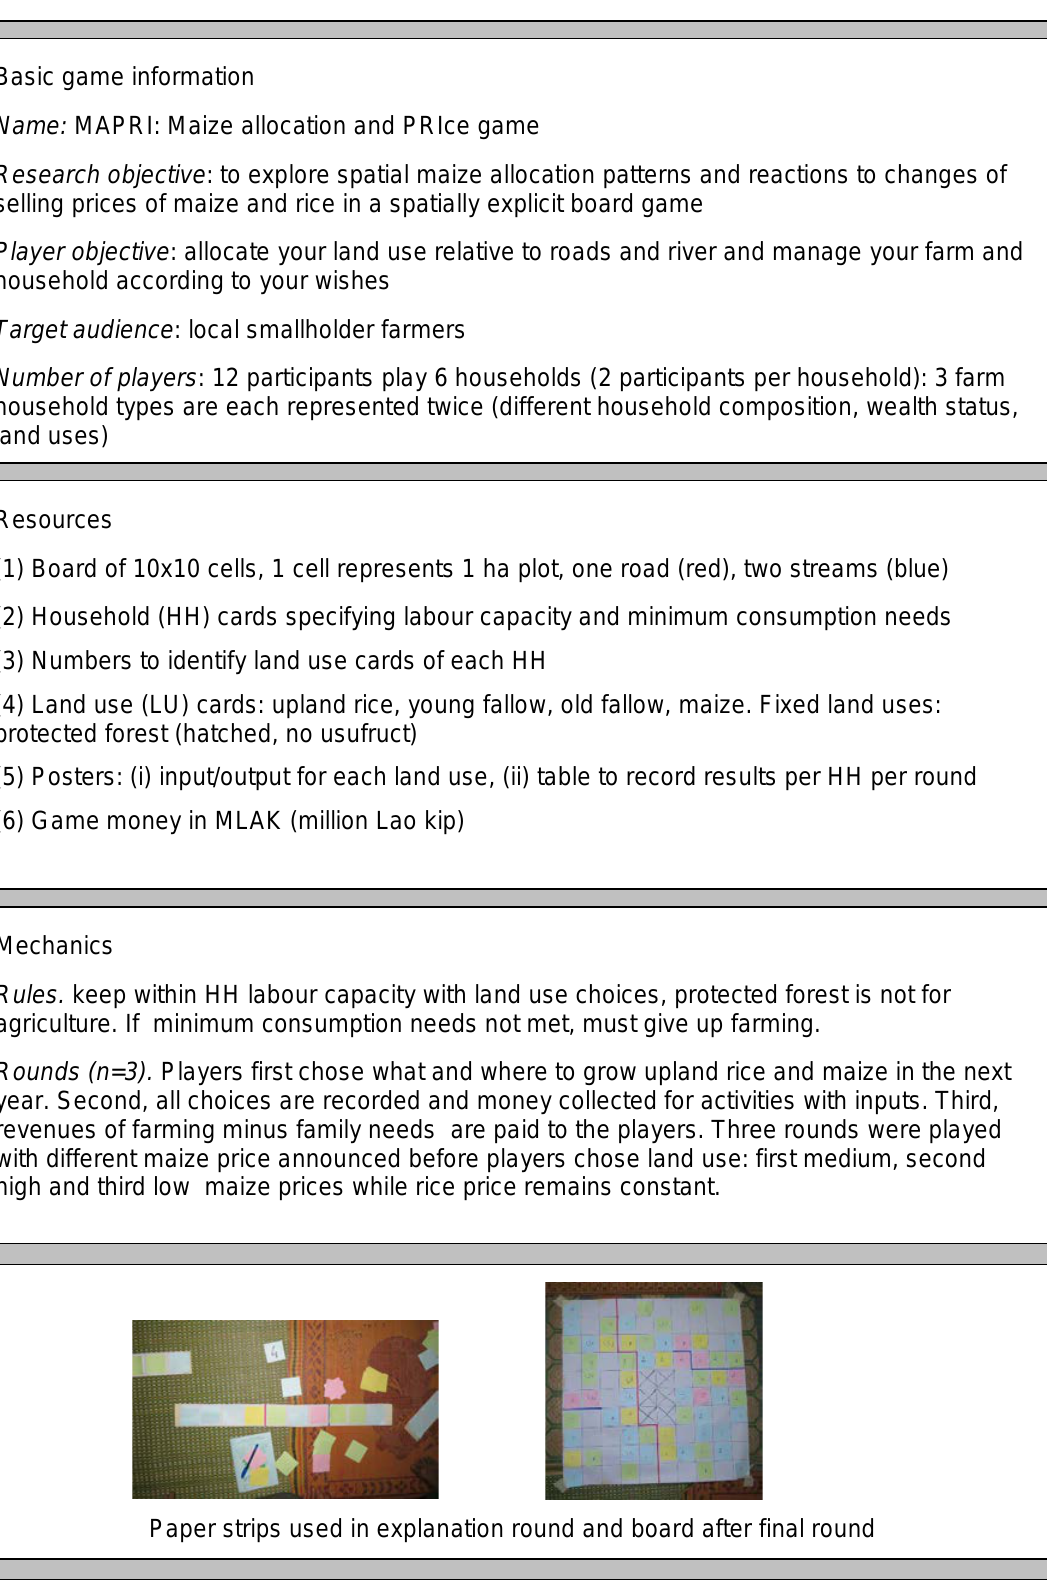
Figure A.2.1. Description MAPRI Board Game developed in Houaykai